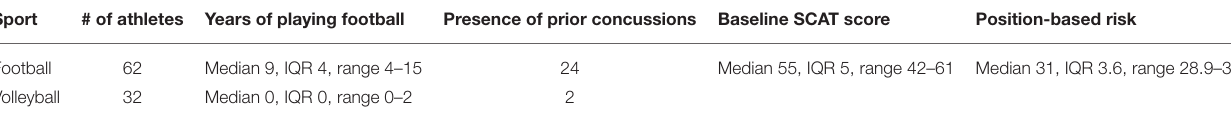
TABLE 1 | Clinical metrics for the study population. Sport